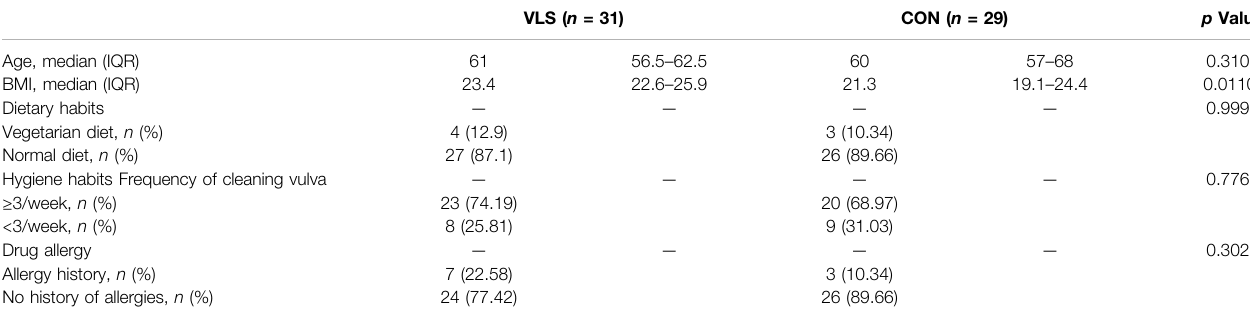
TABLE 1 | The demographic information of the VLS patients and controls.